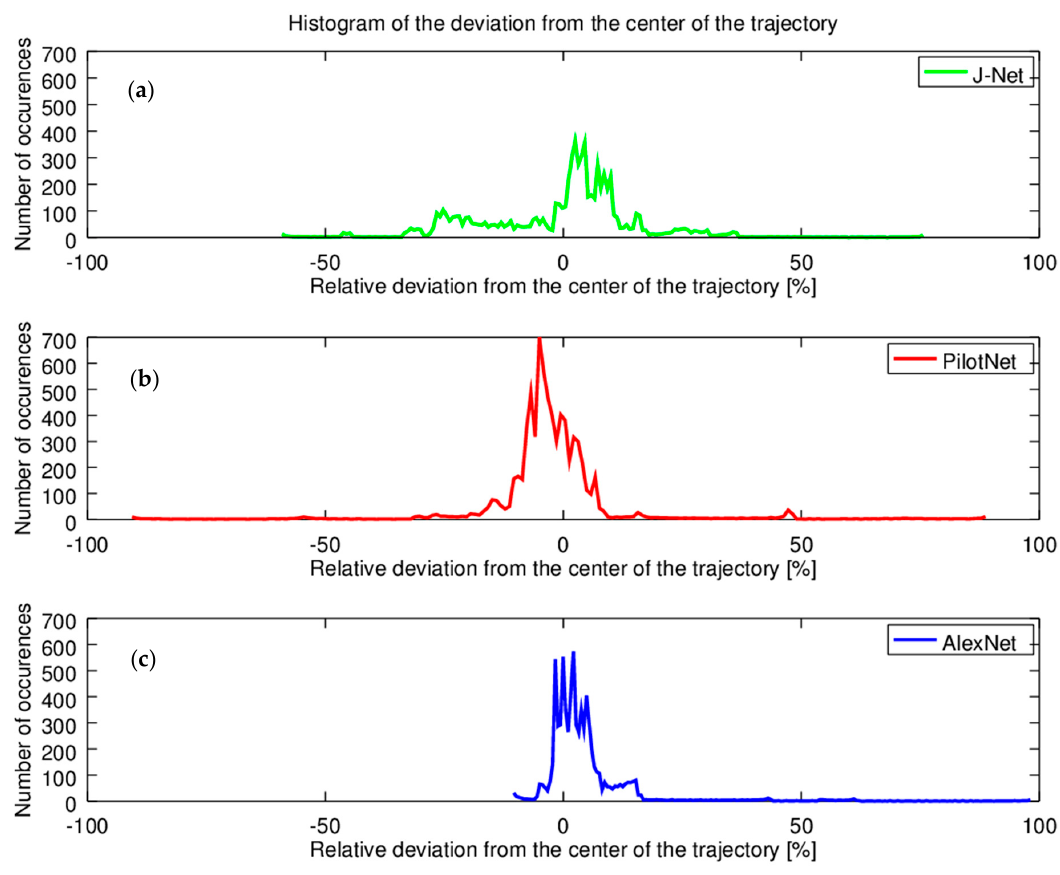
Figure 18. Histograms of deviation from the center of the trajectory per one full lap of autonomous driving. ( a ) J-Net; ( b ) Pilot Net; ( c )